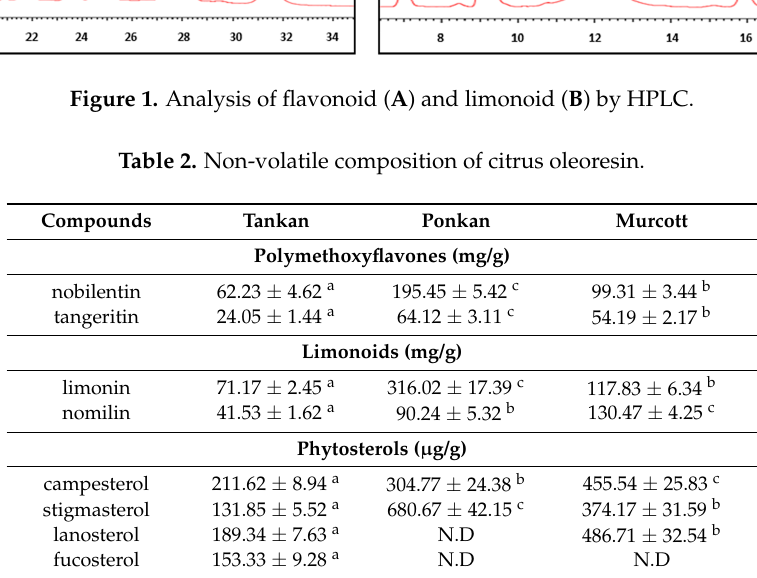
Table 2. Non-volatile composition of citrus oleoresin.